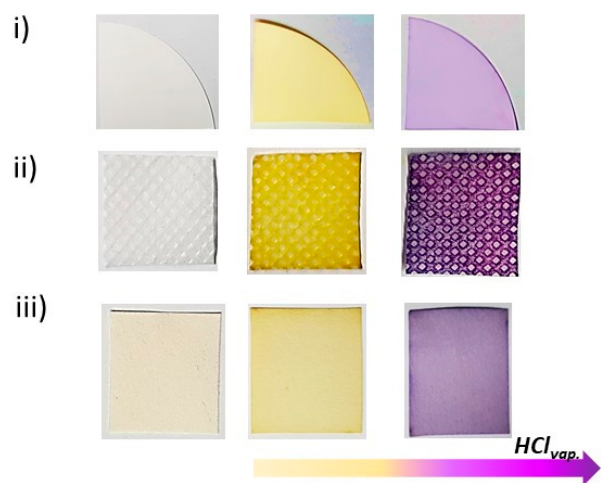
Figure 6. Nylon ( i ), cotton ( ii ), and filter paper ( iii ) dyed by dipping into a 5 mM methanol solution of cyanine 1 . Rows (i)–(iii): Left: before dyeing, middle: dyeing with 1 ; right: after exposure to acidic vapors.